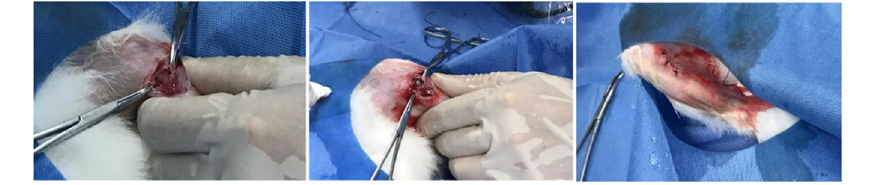
Fig. 2 Rabbits implantation